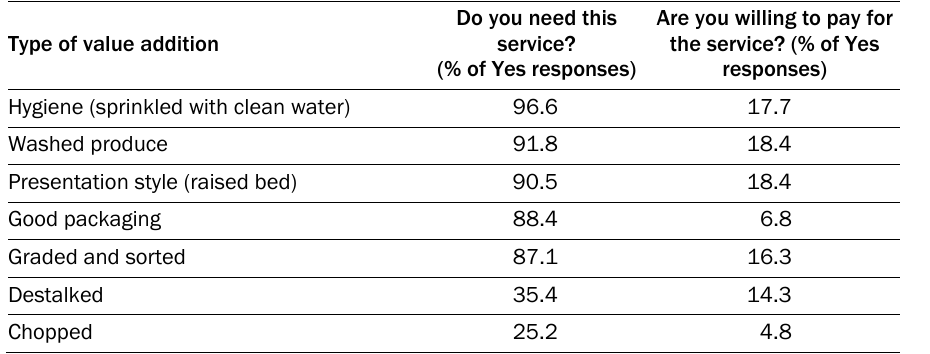
Table 4. Willingness to Pay for Basic Value-Addition Services (%) Among Urban Consumers of Cowpea Leaves ( N